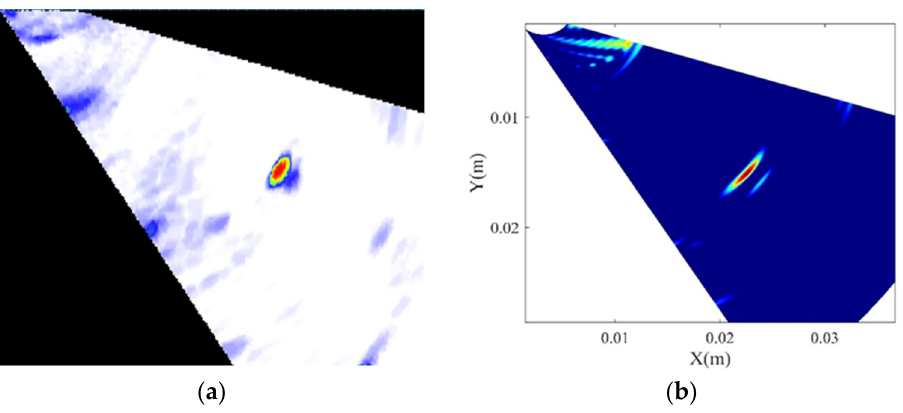
Figure 9. Phased array fan scan image in ( a ) the real experiment and ( b ) the simulation.